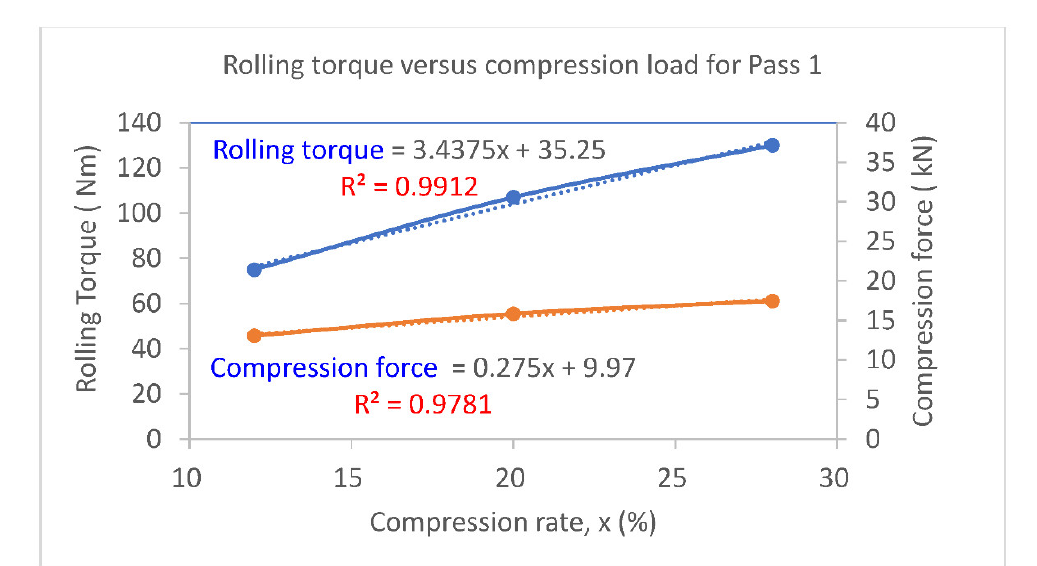
Figure 13. Linear curve fitting of rolling torque and compression load in pass 1.